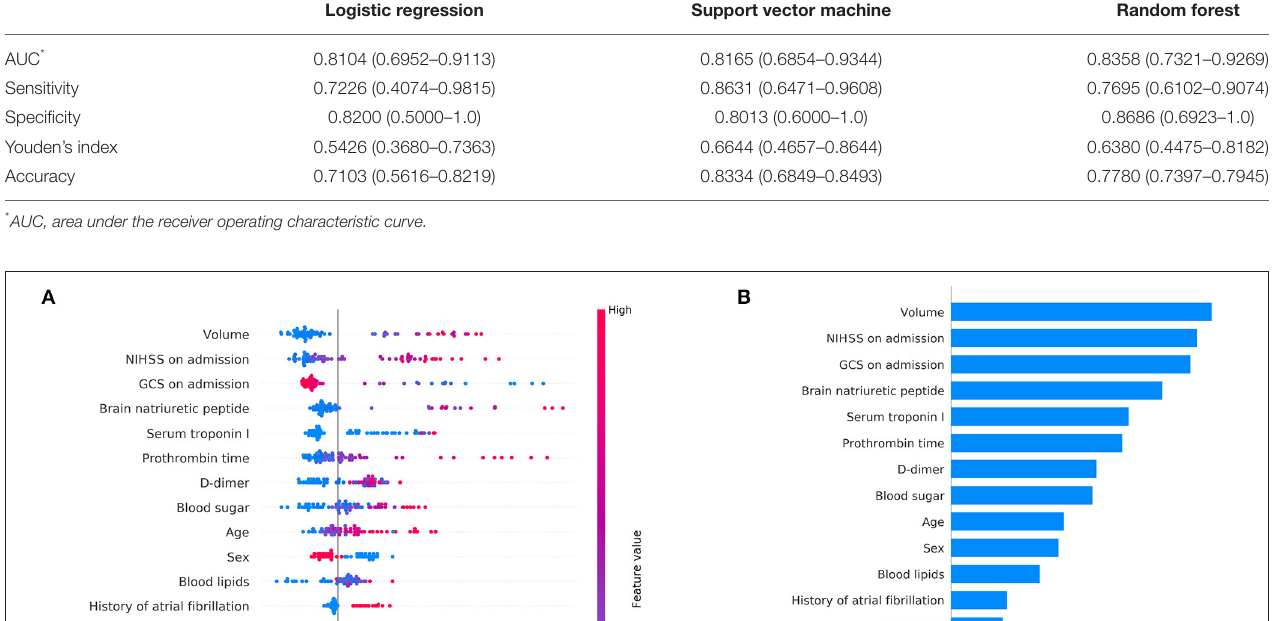
Logistic regression